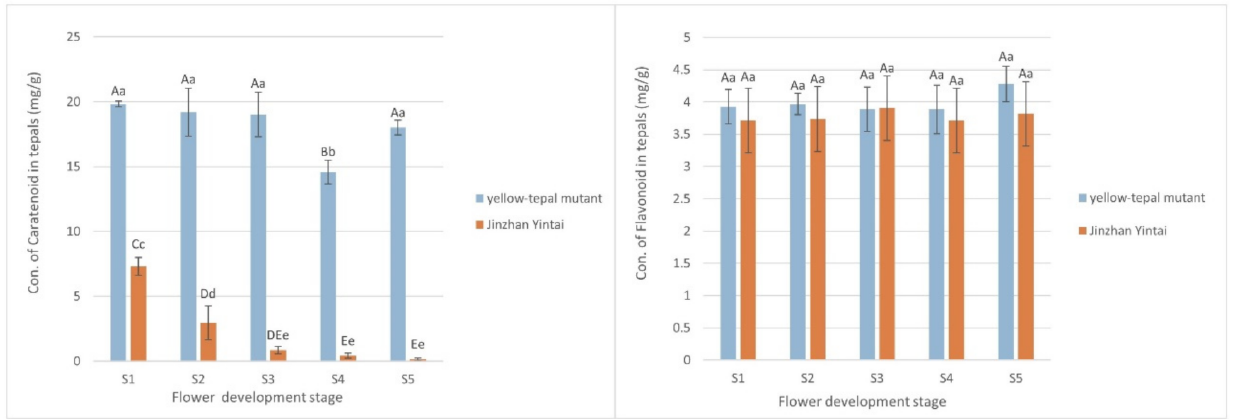
Figure 3. Comparison of the total pigment content in ‘Jinzhan Yintai’ and yellow mutant tepals. The left one shows the comparison of the carotenoid content of the two samples, and the right one shows the comparison of the flavonoid content of the two samples. Different capital letters indicate significant differences at the p < 0.01 level, and different lowercase letters indicate significant differences at the p < 0.05 level; same letter means no significant difference. Error bars represent standard